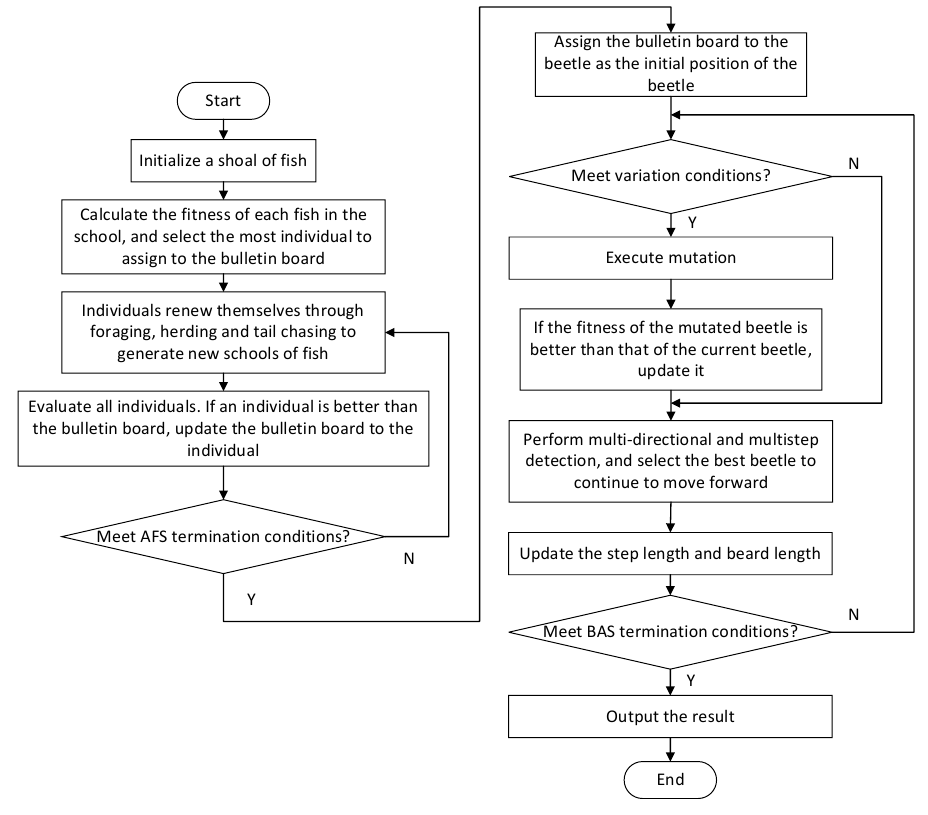
Figure 4. Flow chart of FAS-MMSBAS algorithm.